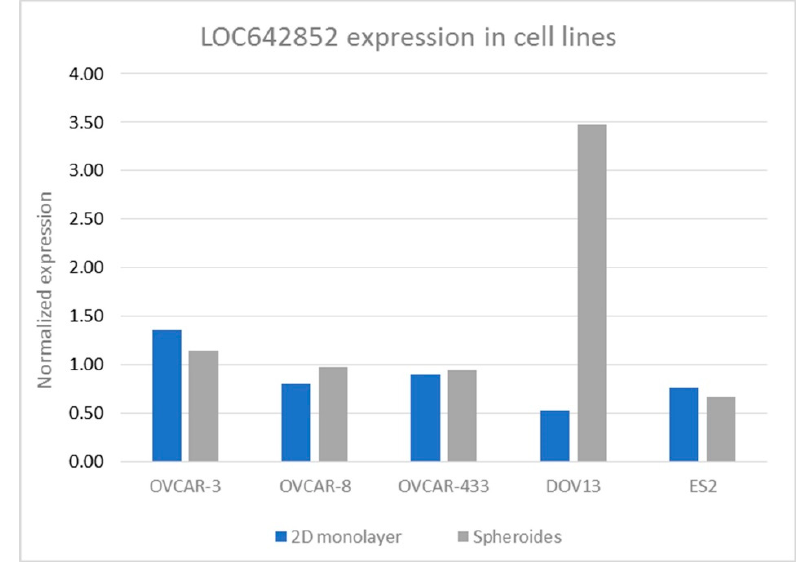
Figure 1. LOC642852 expression in different cell lines cultured in 2D monolayers or spheroids.